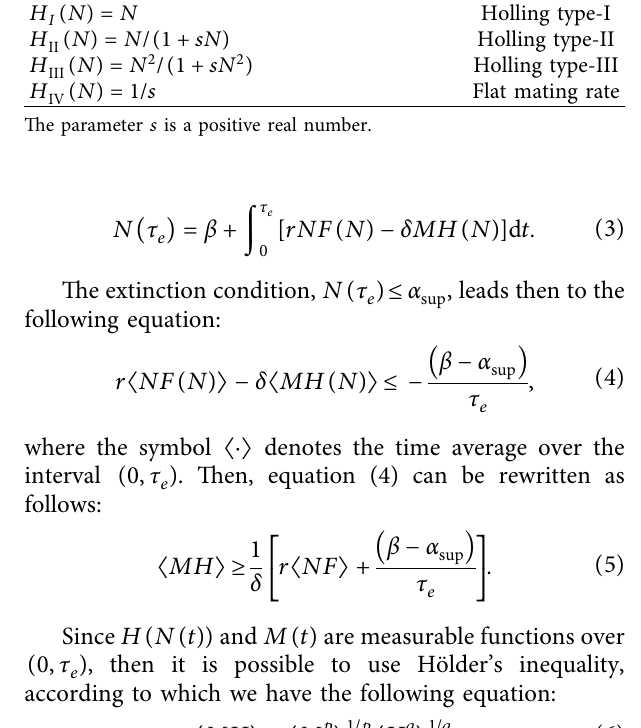
Holling type-II